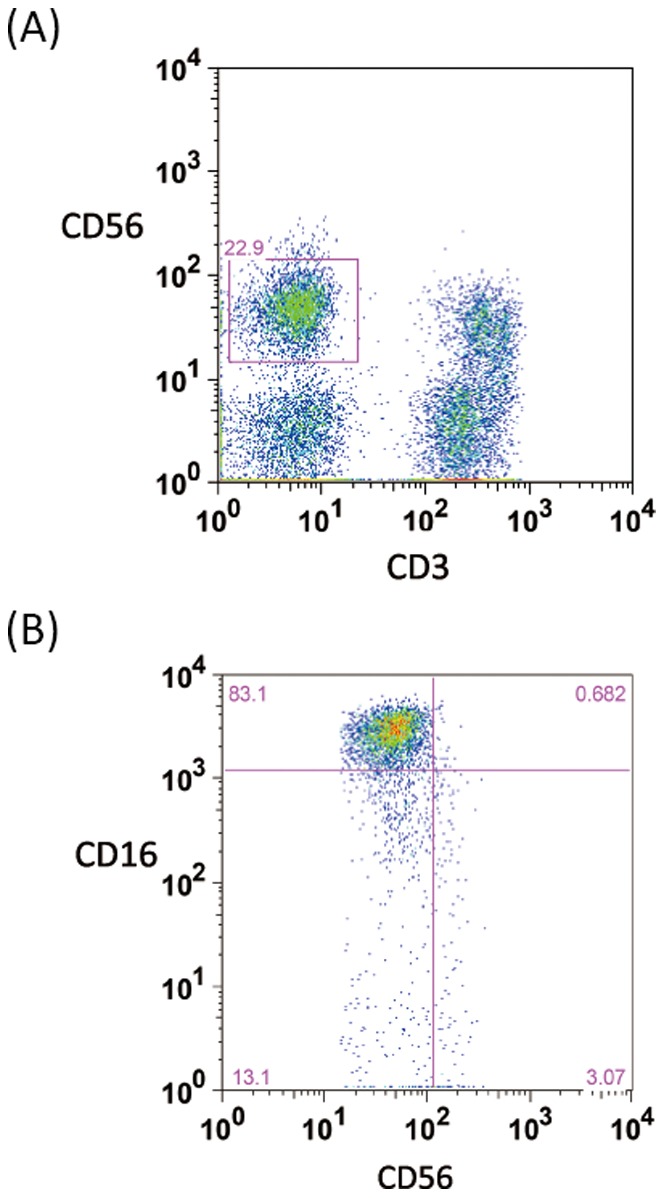
(A) Representative flow cytometric data of the distribution of total NK cell population represented by CD3−CD56+ cells.(B) Representative flow cytometric data of two major NK cell subsets detected in peripheral blood. Left, upper box: CD16+CD56dim NK cell subset. Right, lower box: CD16−CD56bright NK cell subset.